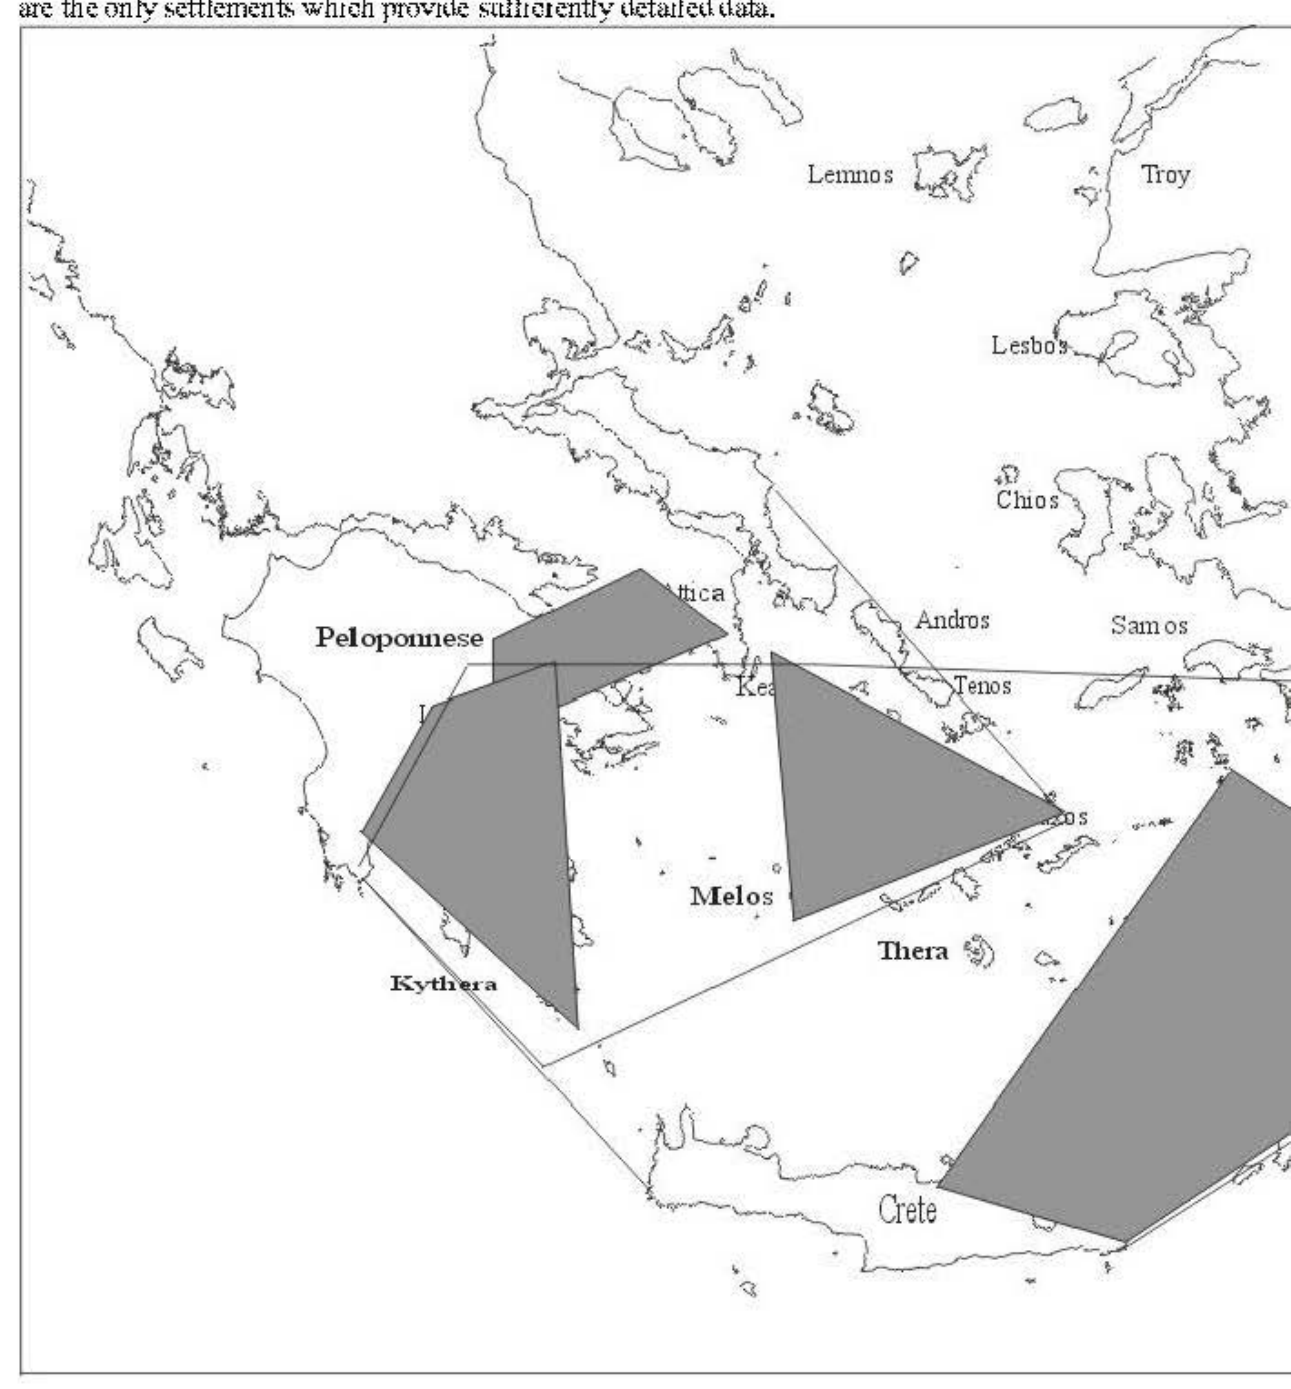
Map 3c: Lo w-ranking Senn peripheries in